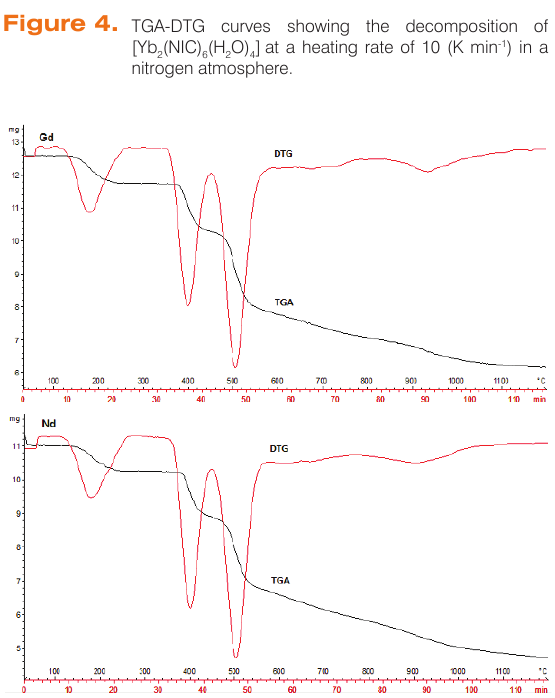
Figure 5. TGA-DTG curves showing the decomposition of